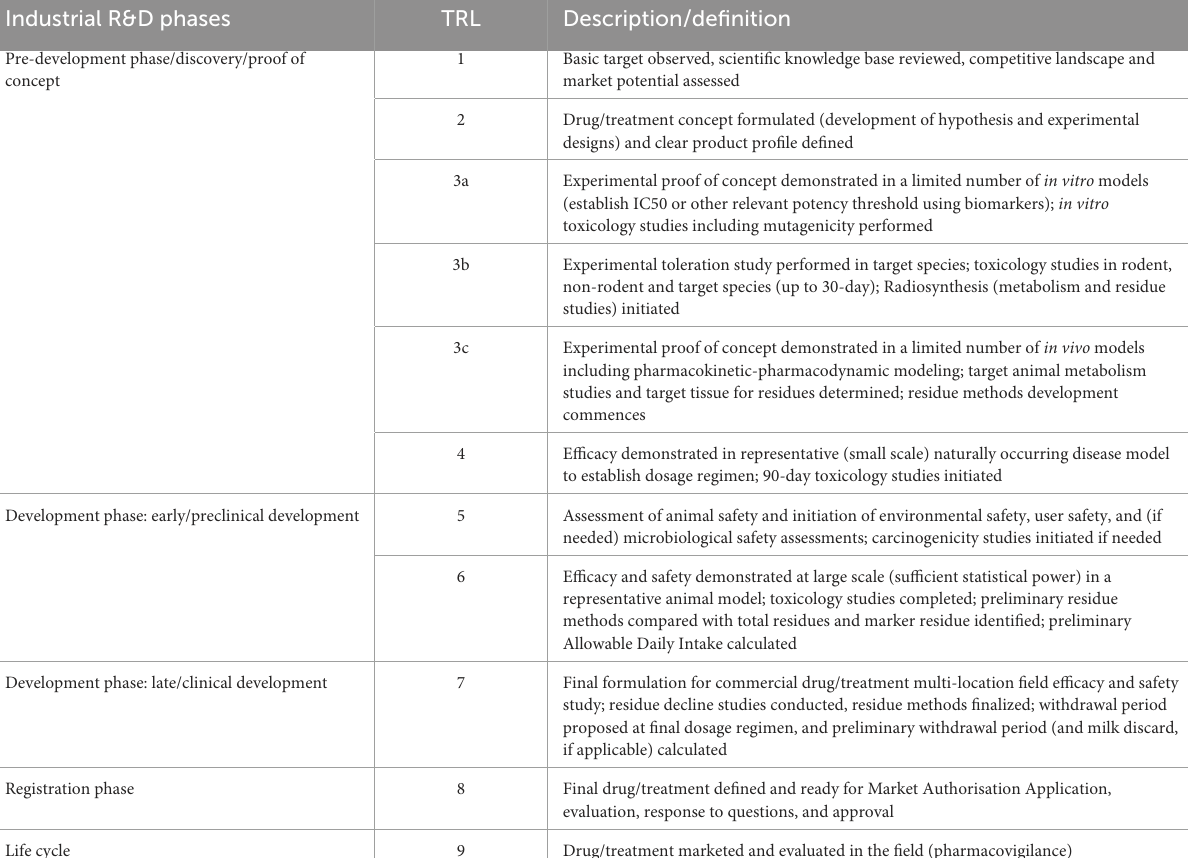
TABLE 2 Technology Readiness Levels for development of drugs for food animals. Industrial R&D phases